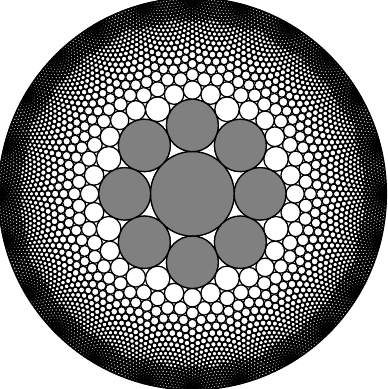
Figure 4.1. A portion of the layered packing generated by the sequence { 8,8,6,6,6, ... } . The circles of degree 8 are